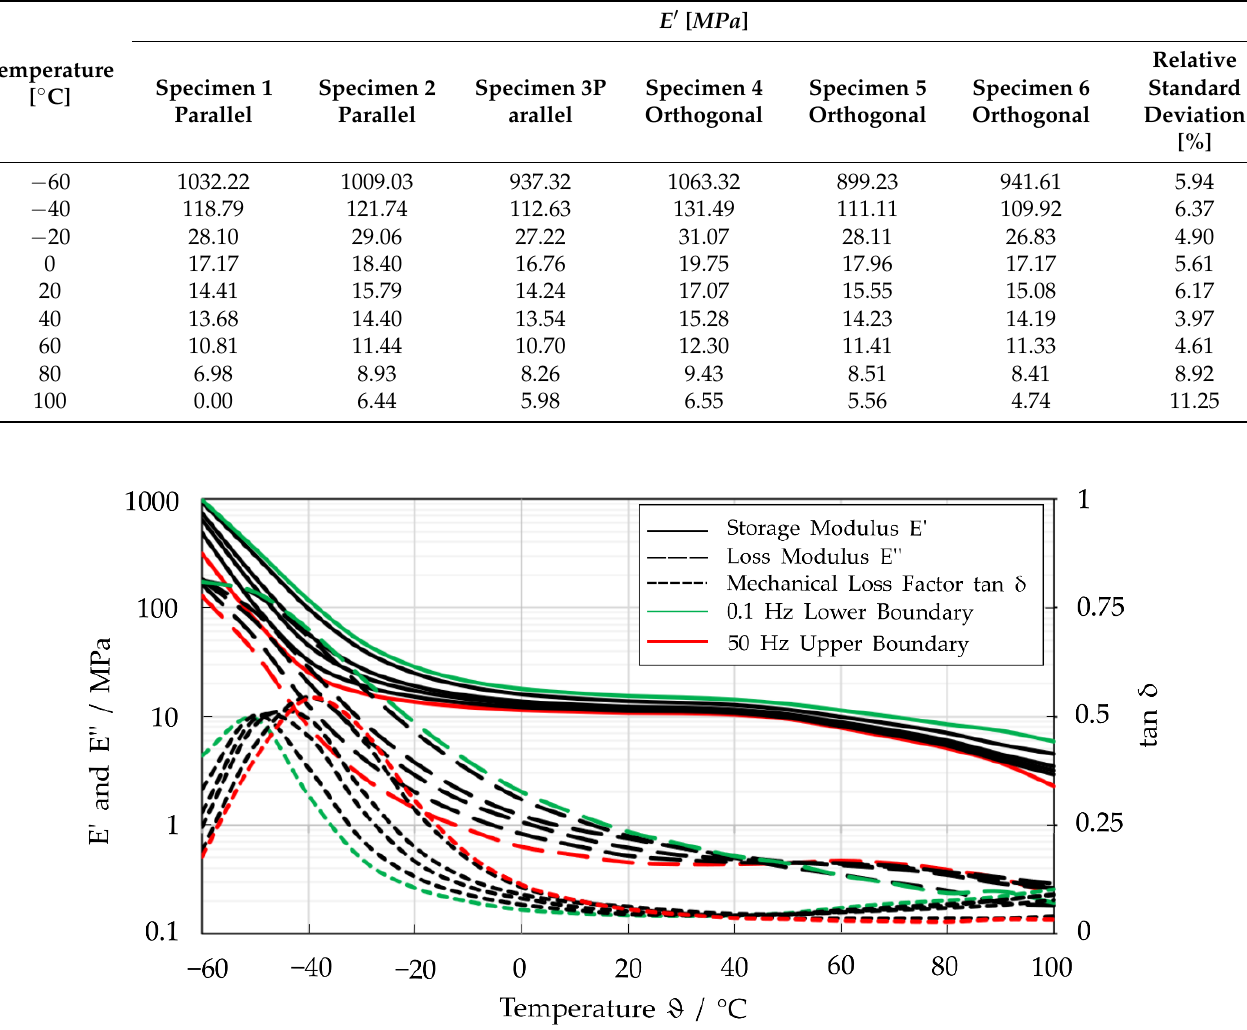
Table 1. Variation of the experimental storage modulus E (cid:48) at 50 Hz.